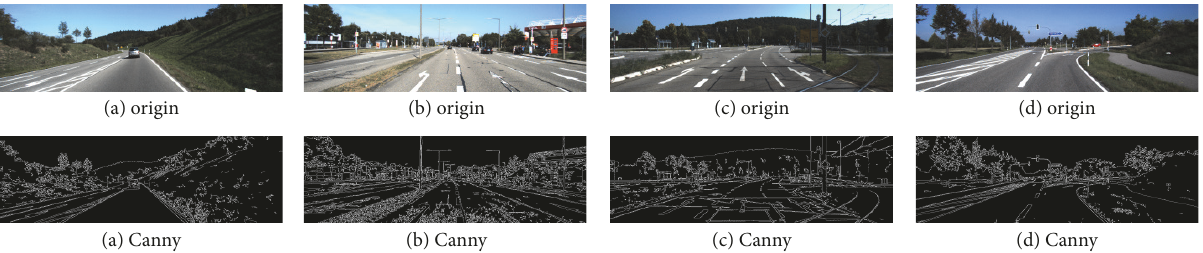
Figure 9: Canny edge detection of sample frames (a), (b), (c), and (d).